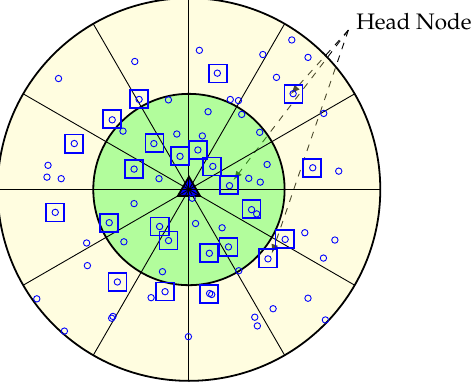
Figure 6. Selection of a Head Node (HN) for each sector. Algorithm 1: Head node selection procedure for